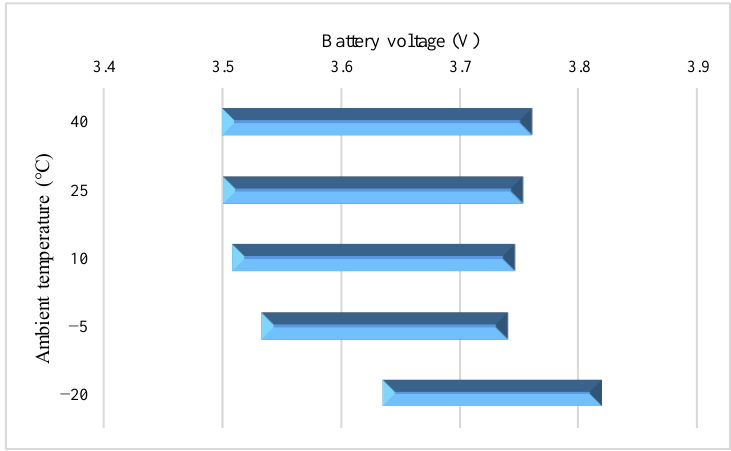
Figure 8. The voltage fluctuation intervals during the VPP with 0.10C charging.